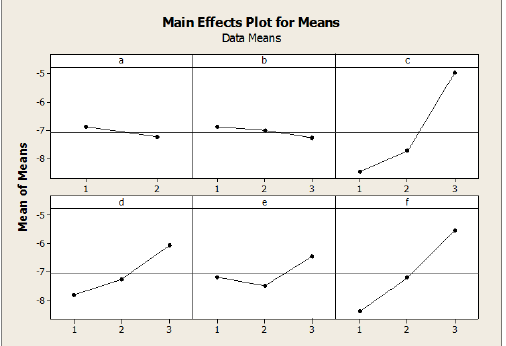
and MRR Fig. 3. Residual Plots for R a